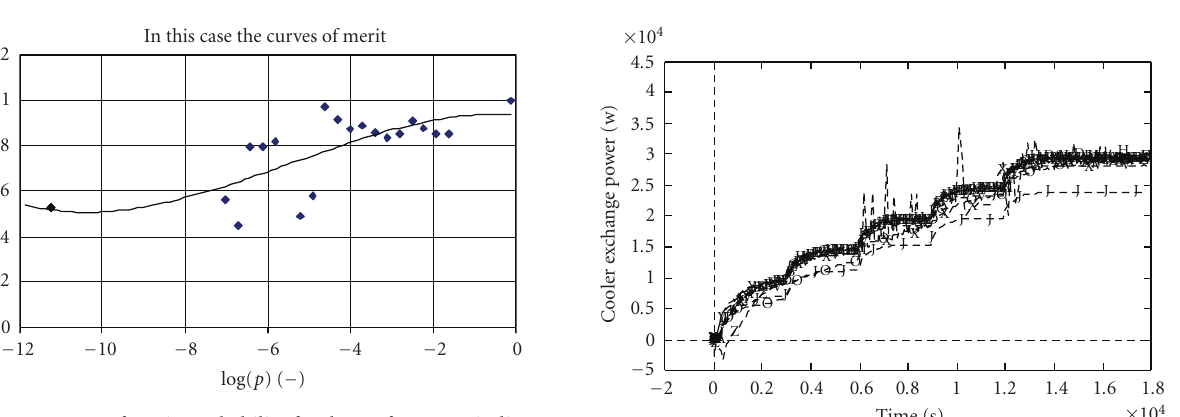
Figure 21: Curves of merit: probability for the performance indica- tor “IC power integral ratio” (discrete probability distribution).